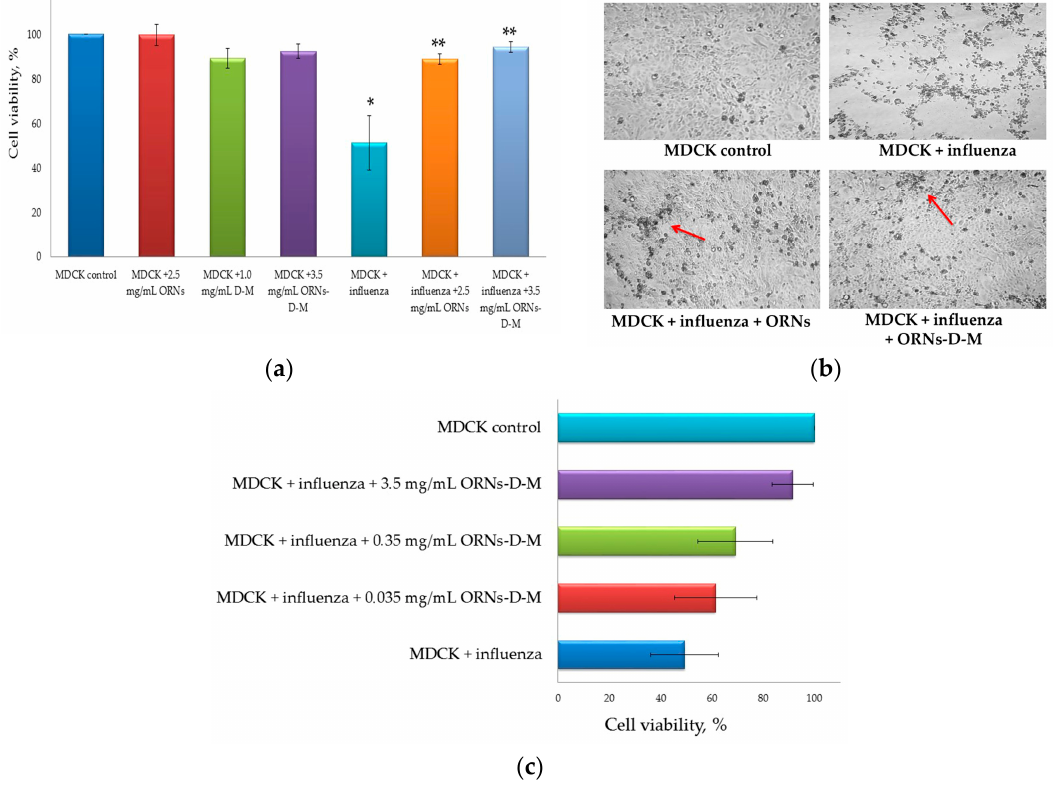
Figure 3. ( a ) Increased viability of MDCK cells infected influenza A virus H1N1 (A/FM/1/47) owing to the ORNs and ORNs- D -M; ( b ) Inhibition of the influenza virus -induced CPEs by the ORNs and ORNs- D -M in MDCK cells; ( c ) Increased viability of the cells infected with the influenza virus preincubated with the ORNs- D -M was in a dose-dependent manner. MDCK control: normal cells without influenza and drugs; MDCK + ORNs: cells incubated with 2.5 mg/mL of the ORNs; MDCK + D-M: cells incubated with 1.0 mg/mL of the D-M; MDCK + ORNs- D -M: cells incubated with 3.5 mg/mL of the ORNs- D -M; MDCK + influenza: cells infected with influenza virus without drug preincubation; MDCK + influenza + ORNs: cells infected with influenza virus preincubated with 2.5 mg/mL of the ORNs; MDCK + influenza + ORNs- D -M: cells infected with influenza virus preincubated with 3.5, 0.35, and 0.035 mg/mL of the ORNs- D -M. The cell viability was tested by MTT assay and the virus-induced CPEs were observed under a light microscope. Data are shown as the mean ± SD for five independent experiments. Statistical significance was evaluated using the Student’s t -test, relative to the cell control (* p < 0.05) and to the virus control (** p < 0.05).